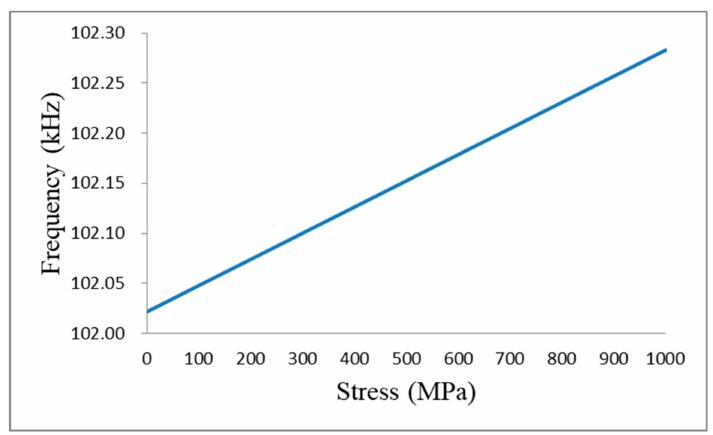
Figure 5. Stress-frequency simulation of the 10 m steel strand.